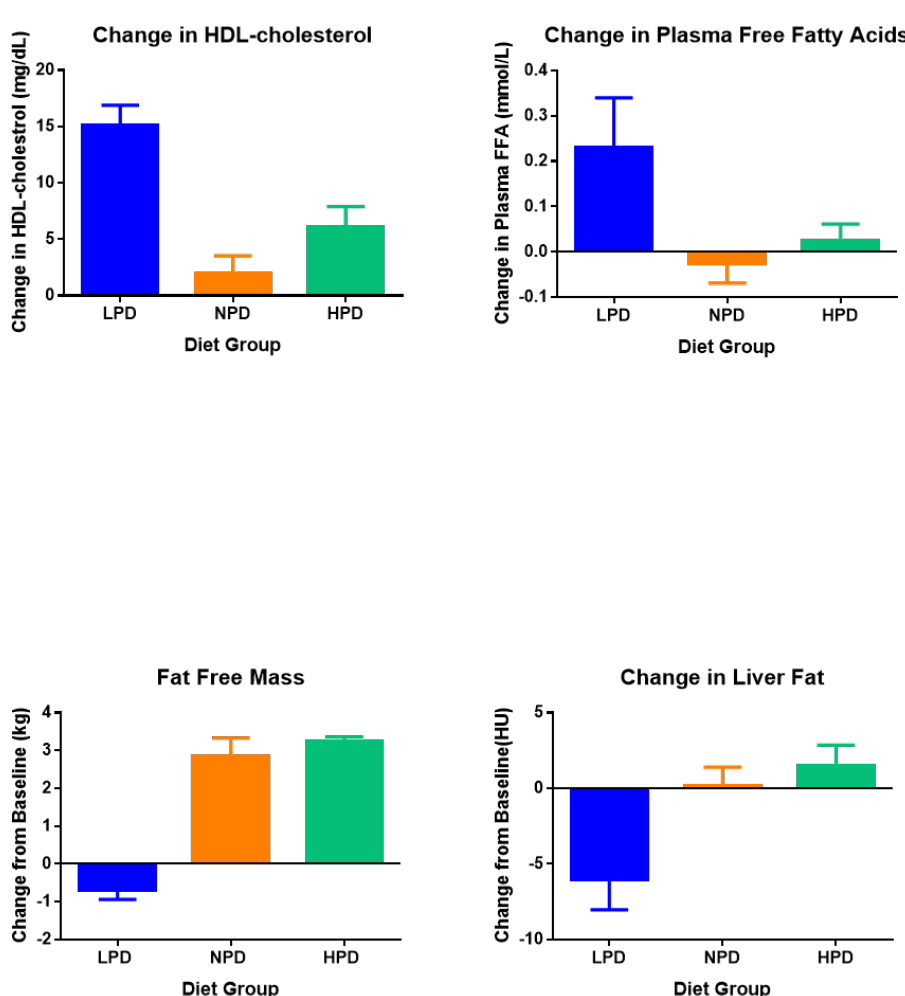
Figure 1. Changes in HDL-cholesterol, plasma free fatty acids, fat free mass, and liver density during overfeeding with diets containing di ff erent levels of dietary protein. (Tukey–Kramer analysis shows that for HDL-cholesterol: LPD > NPD ( p < 0.0001) and HPD ( p = 0.0072); For plasma free fatty acids: LPD > NPD ( p = 0.034) NPD = HPD; for liver density: LPD > NPD ( p = 0.038) and HPD ( p = 0.012); for fat free mass: LDP < NPD and HPD ( p < 0.0001). There were not significant di ff erences between the NPD and HPD groups in any of the